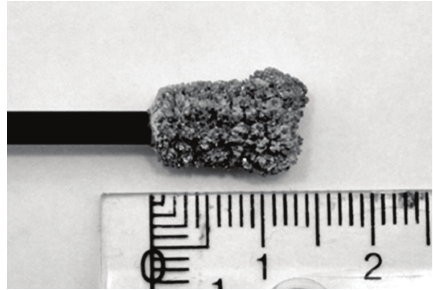
Figure 6: Indium metal from electrodeposition from the copper- depleted synthetic solution after copper separation using a potential of − 0.9